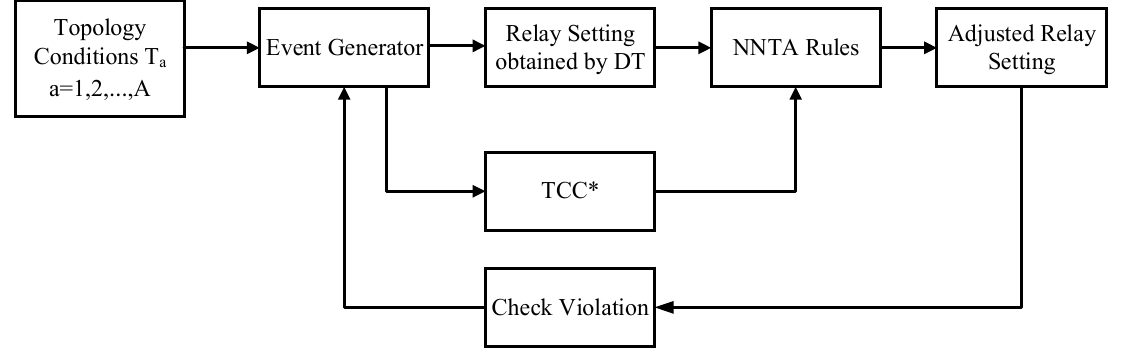
Figure 4. Close-loop training block of the NNTA.